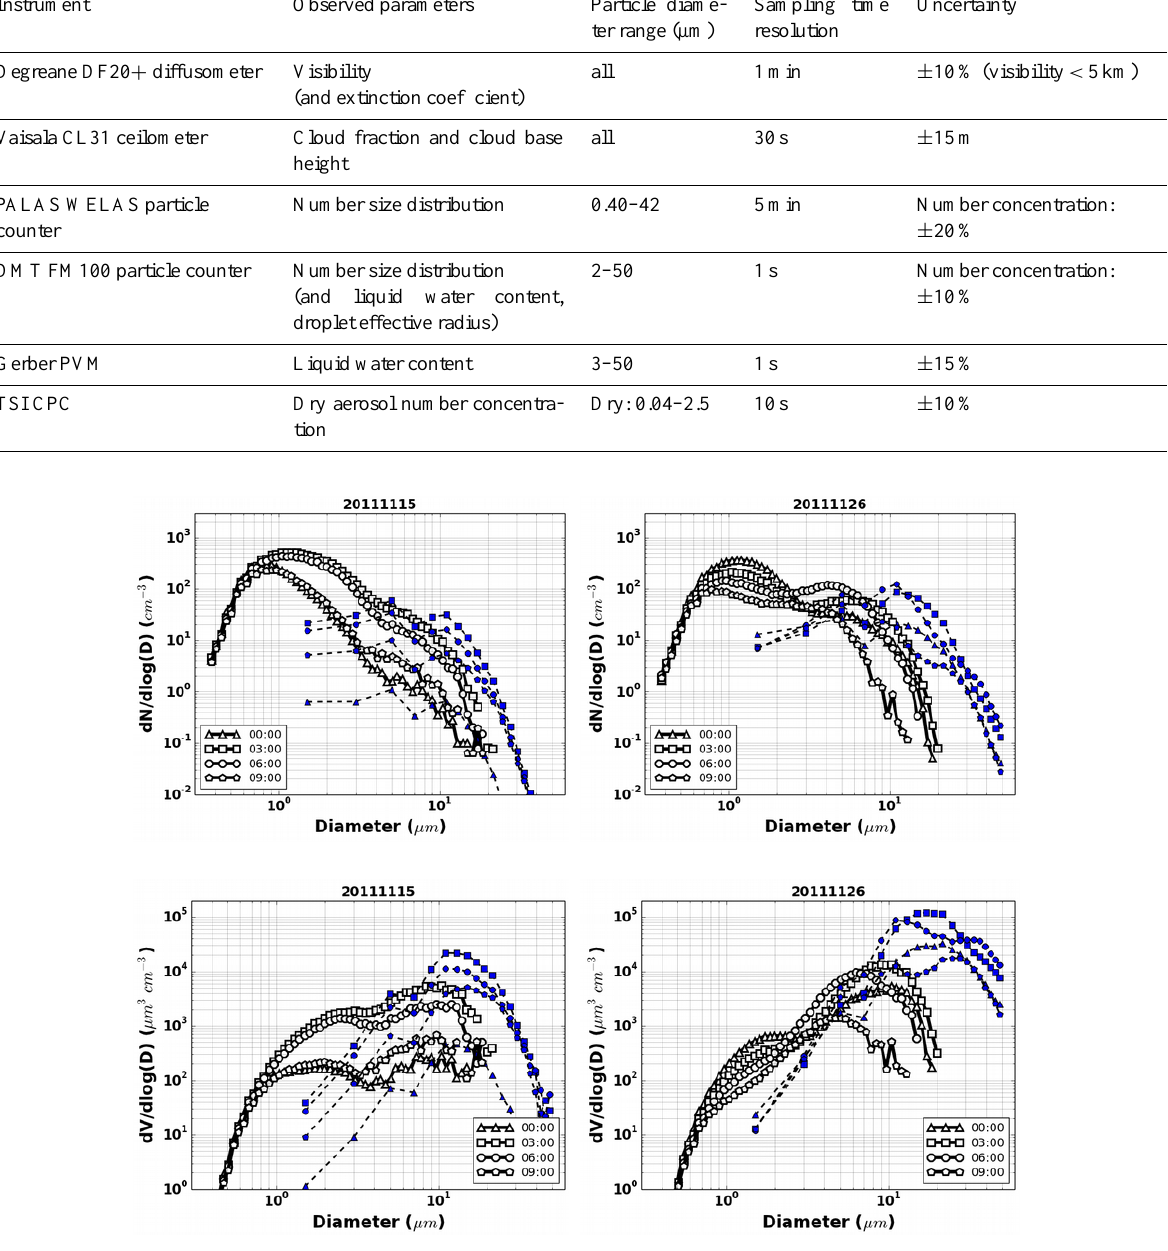
Figure 1. Number (top) and volume (bottom) size distributions measured by the WELAS (open symbols) and by the FM100 (blue filled symbols and dashed lines) during the f5 and f6 fogs of 15 November 2011 (left) and the f16 fog of 26 November 2011 (right), averaged over